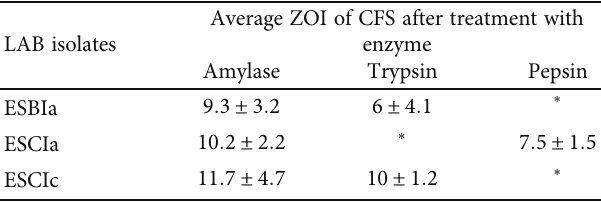
Table 7: Antimicrobial activity of enzyme-treated CFS. Average ZOI of CFS after treatment LAB isolates